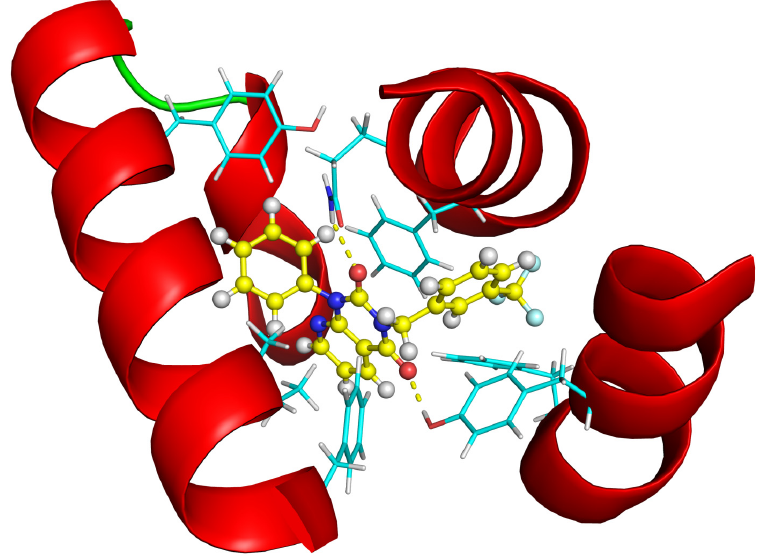
Figure 12. The structure of the Glide XP calculated PDE4B—#3 (2nd round hit) complex. Ligand carbon atoms are marked in yellow, while the nearest interacting protein residue side chains are shown in cyan color. The yellow dotted lines represent inter-molecular hydrogen bonds.